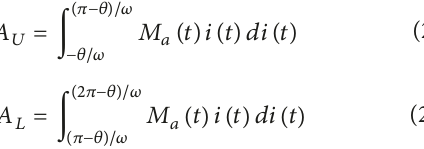
and 𝐴 𝐿 . Since V (𝑡) = 𝑀 𝑎 (𝑡)𝑖(𝑡) at asymptotic state where 𝑀 (𝑡) denotes the asymptotic approximation of 𝑀(𝑡) , 𝐴 𝑎 and 𝐴 𝐿 can be given